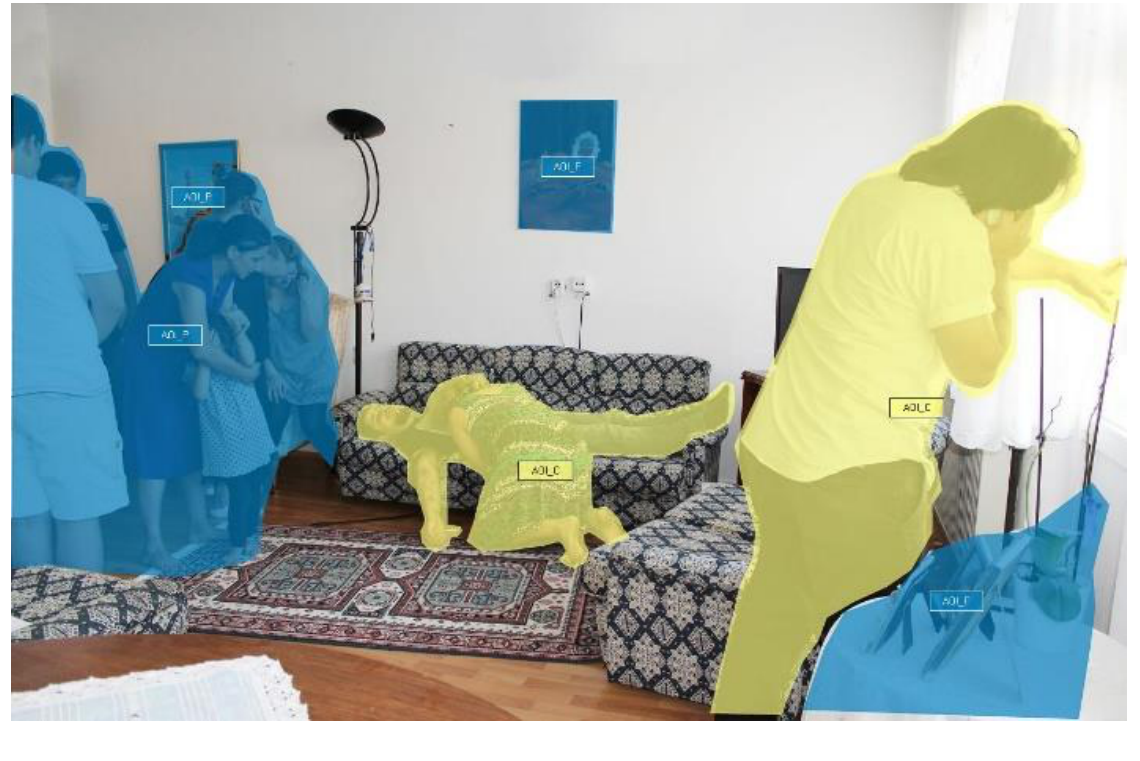
Figure 1 Area of Interests (AOIs) for negative thematic photograph (Central AOIs: AOI-C and Peripheral AOIs: AOI-P)